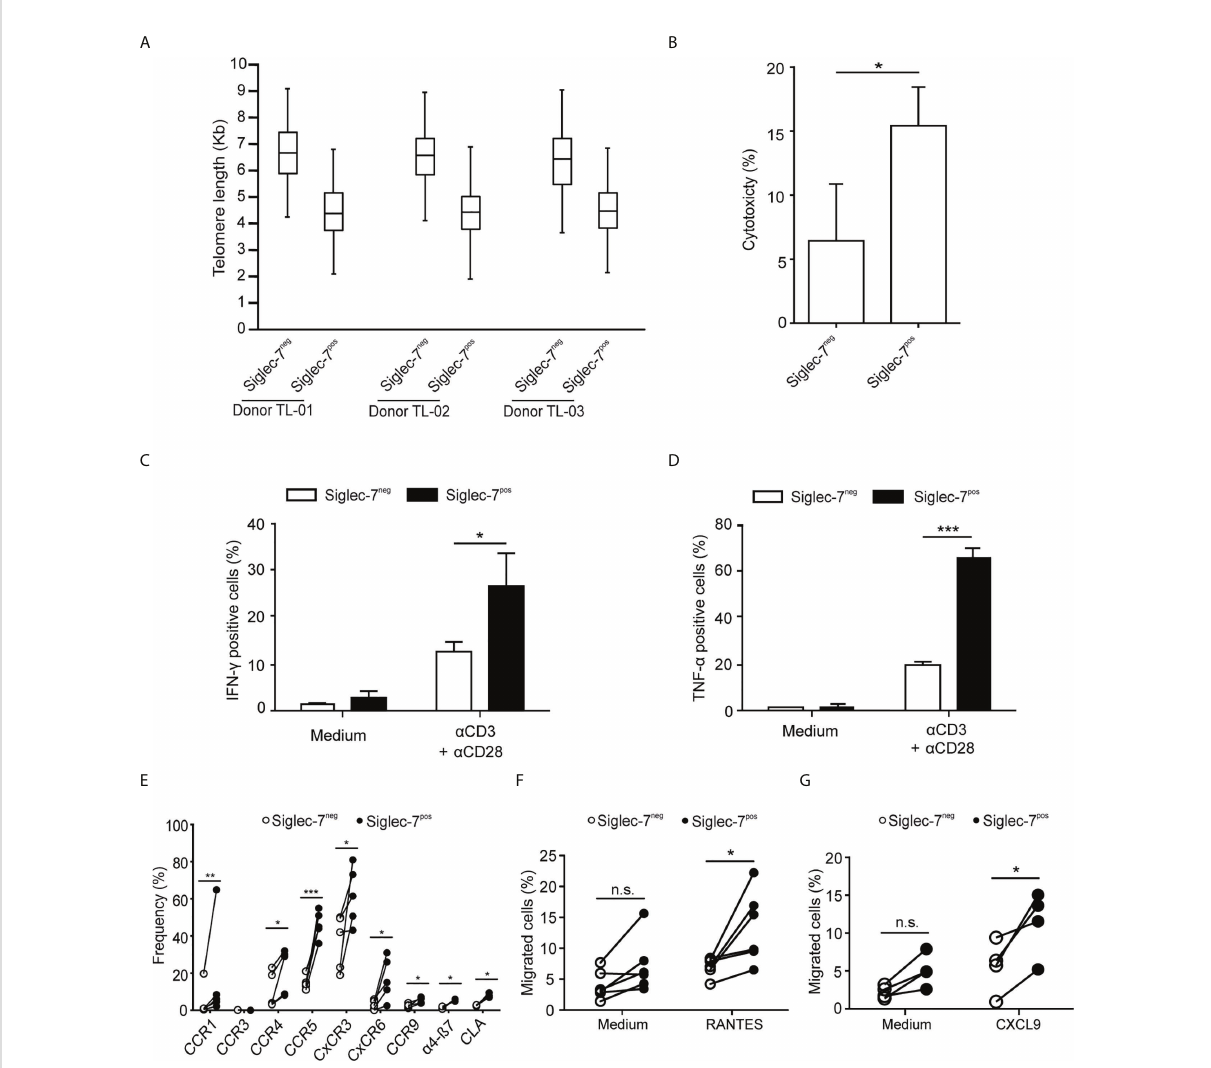
FIGURE 4 Siglec-7+ CD8+ T cells display a highly proliferative and functional phenotype. (A) Telomere length analysis of CD8 + T cell subsets from three healthy donors. Box plot representation indicating 25 th to 75 th percentiles with median; error bars, 1 st to 99 th percentiles. (B) Redirected cytotoxicity of CD8 + T cell subtypes upon co-culture with a CD3 – loaded P815 tumor cells for 4 h (n=4). (C, D) Flow cytometric quantitative analysis of intracellular IFN- g or TNF- a production by CD8 + T cell subsets following 5 h of culture upon costimulation by a CD3 and a CD28 (each at 1 m g/mL; n=5). (E) Flow cytometric quantitative analysis of chemokine receptors on the surface of CD8 + T cell subsets (n=5). (F, G) Migration of CD8 + T cell subsets towards 100 ng/mL of RANTES (E, n=6) or CXCL9 (F, n=5) through transwell inserts with 5 m m pores after 4